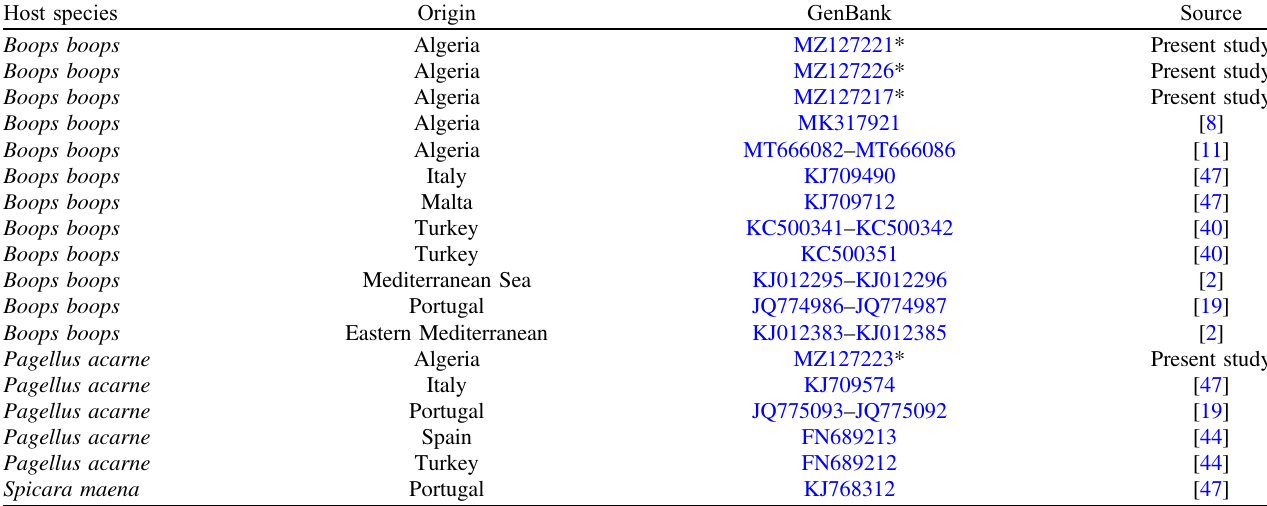
Table 3. Accession numbers of COI sequences used in the molecular analysis of fi shes. Species previously reported as hosts of Cyclocotyla bellones or as hosts for isopods bearing the latter are in bold. Note that all hosts are sparids. Choricotyle chrysophryi is a parasite of the fi sh, so no isopod was involved. *, new sequences.